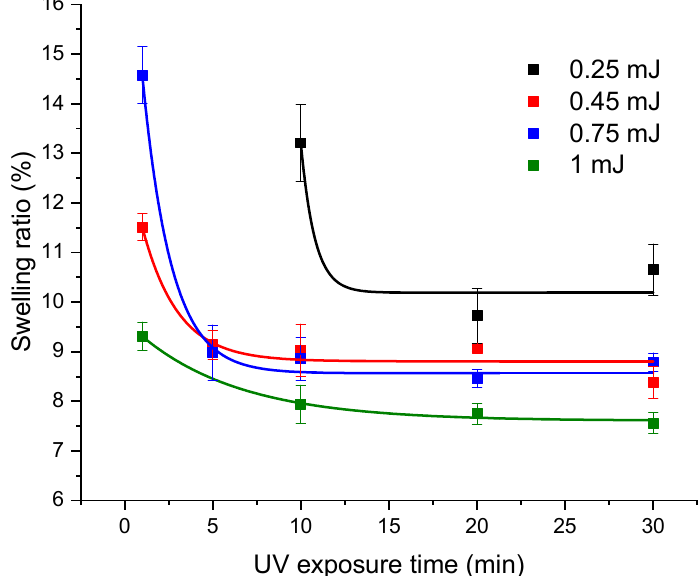
Figure 3. Influence of laser beam energy and exposure time on the swelling behavior of GelMa hydrogel photo-crosslinked when Irgacure (0.05%)-GelMa (10%) solutions were exposed 1, 5, 10, 20, 30 min to 0.25, 0.45, 0.75, and 1 mJ laser beams.